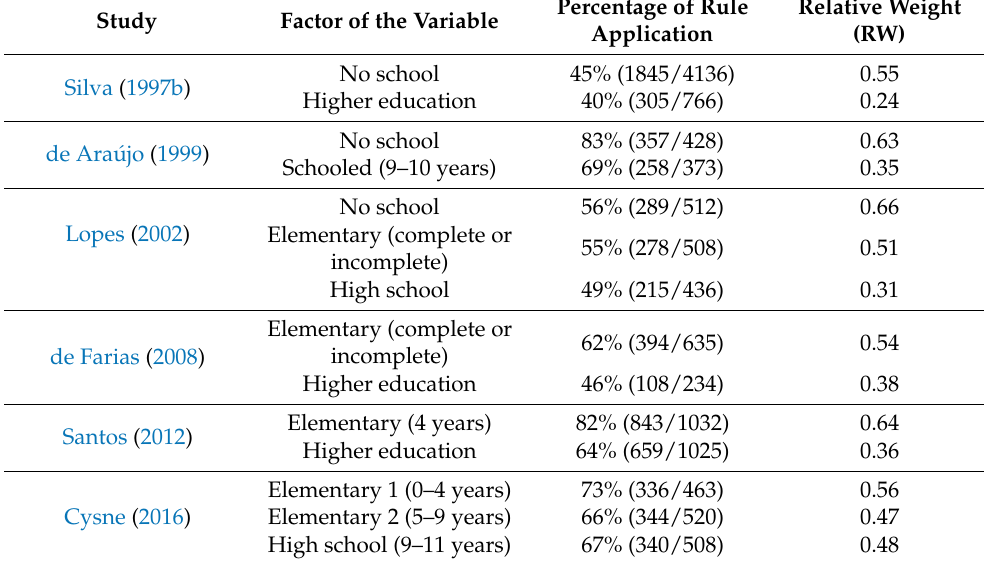
Table 3. Effects of the factors of the variable education level